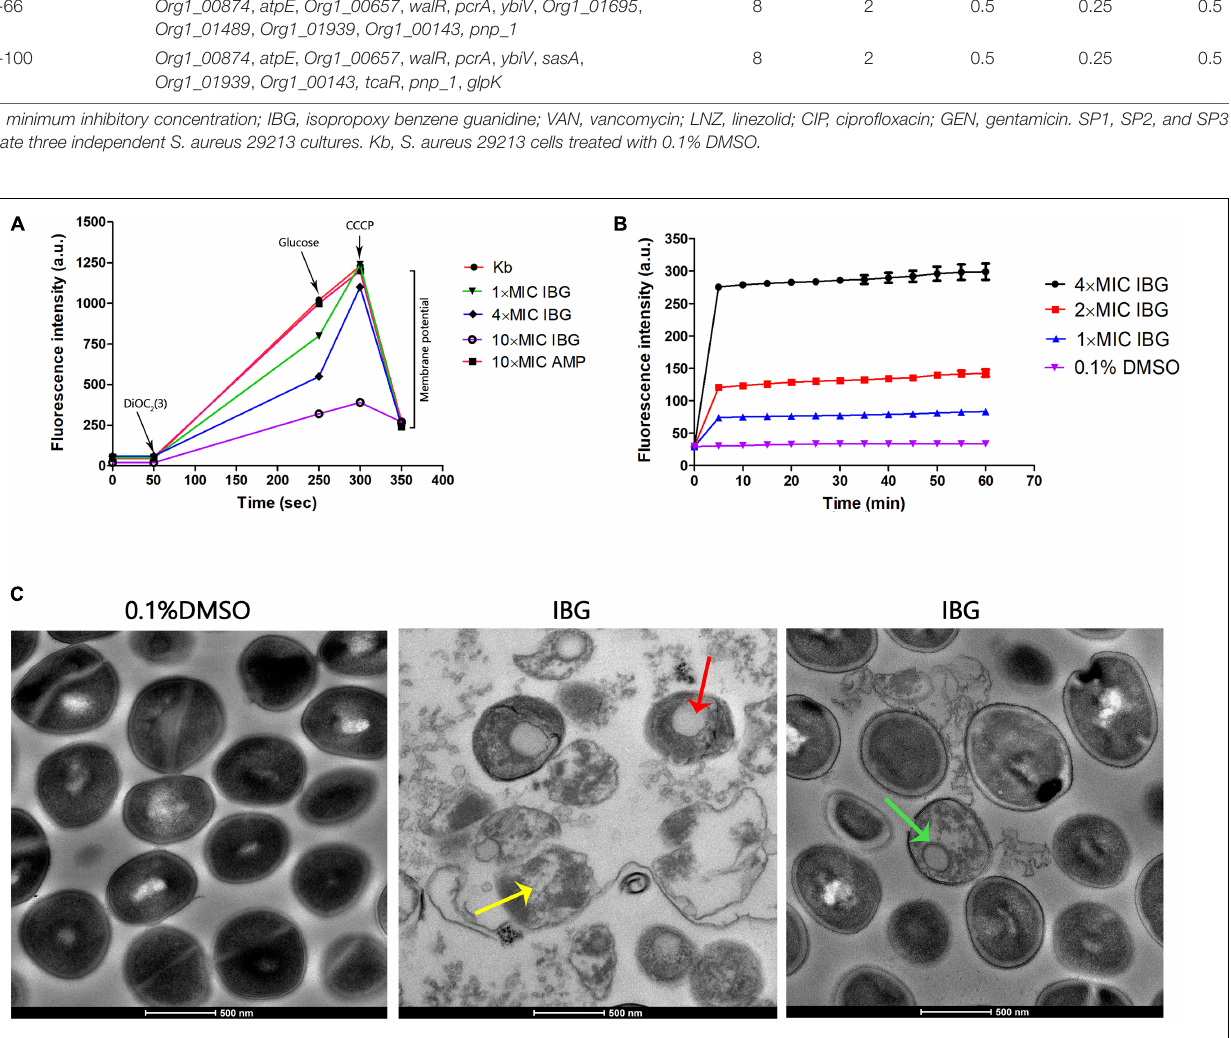
Frontiers in Microbiology |